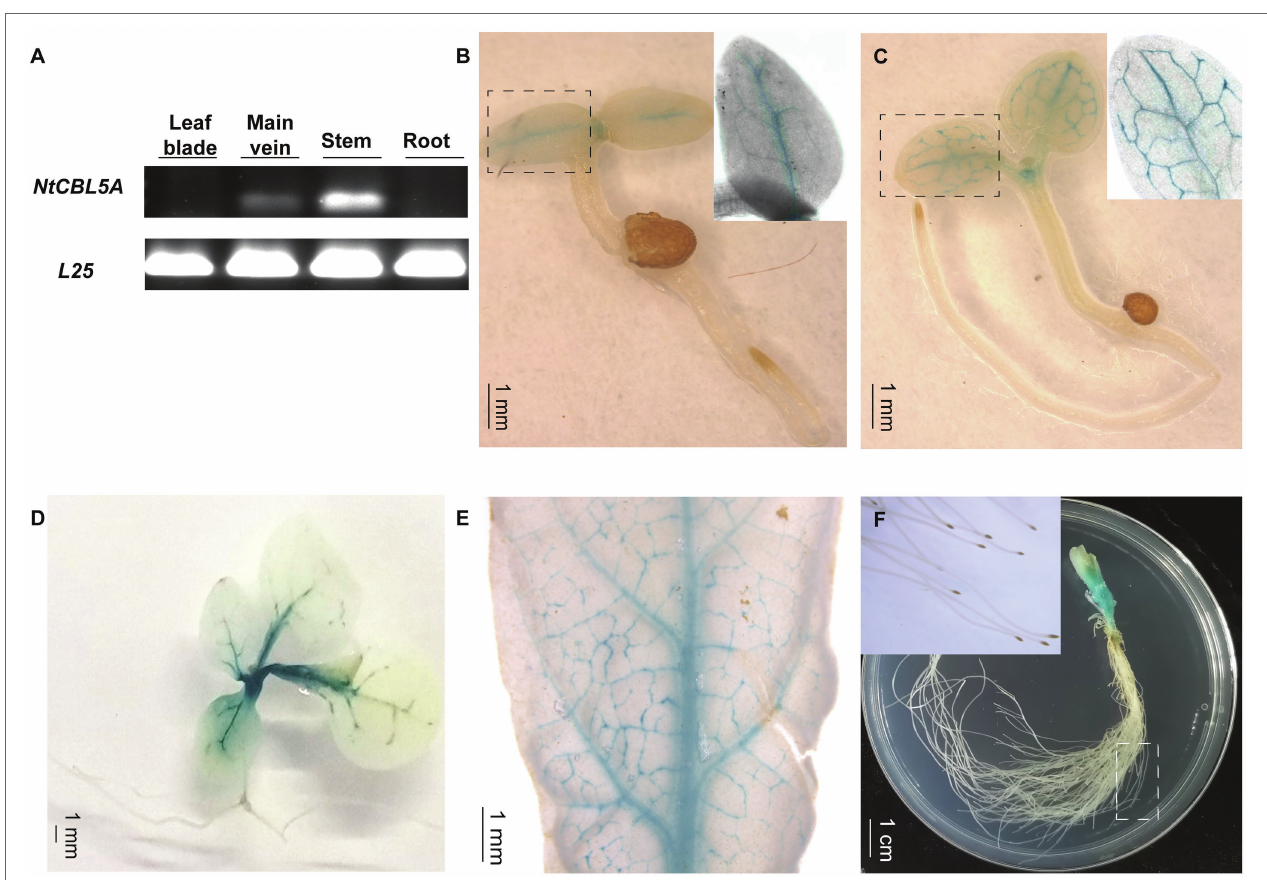
FIGURE 2 | The expression profile of NtCBL5A in tobacco plants. (A) The expression profile detection in different tissues by semi-quantitative RT-PCR at 30 days after germination (DAG), L25 is the reference gene (Schmidt and Delaney, 2010). (B-F) The GUS staining of different tissues of ProNtCBL5A::GUS plants at different growth stages. They are seedlings at 3 DAG (B) , seedlings at 5 DAG (C) , seedlings at 20 DAG (D) , leaves of the seedlings at 40 DAG (E) , and stem and root tissues of the seedlings at 40 DAG (F) ,